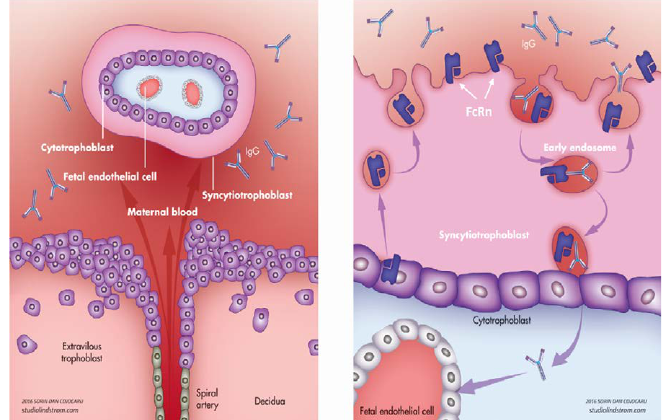
Figure 1. Transplacental passage of immunoglobulin G (IgG) and the neonatal Fc receptor. IgG from the maternal blood (left) is transferred by transcytosis at the level of syncytiotrophoblasts (STB); it is internalized within endosomes and binds to FcRn on the internal surface; the complex is then carried towards the basal cell membrane of STB and released into the fetal circulation (right). Purple arrows indicates IgG transport to the fetal blood.